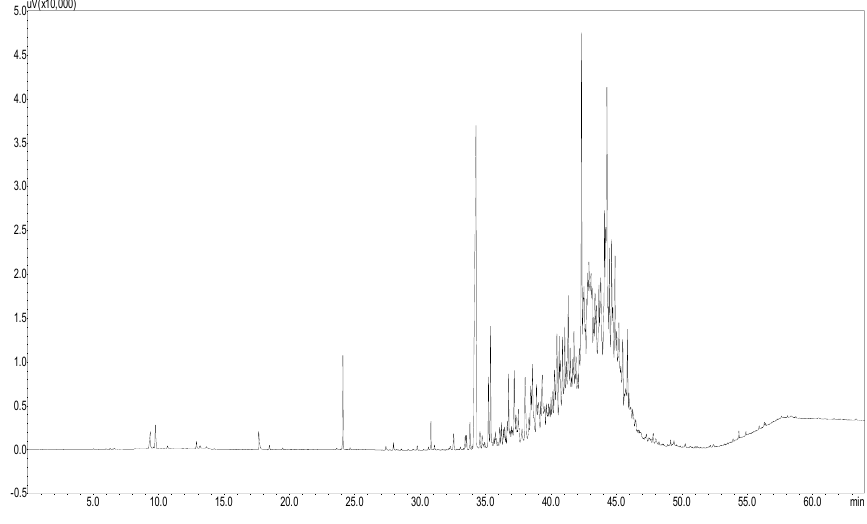
Figure 3. Chromatogram for the volatile organic compounds emitted from different types of wallpapers. ( a ) PVC-coated wallpaper, ( b ) Non-PVC-coated